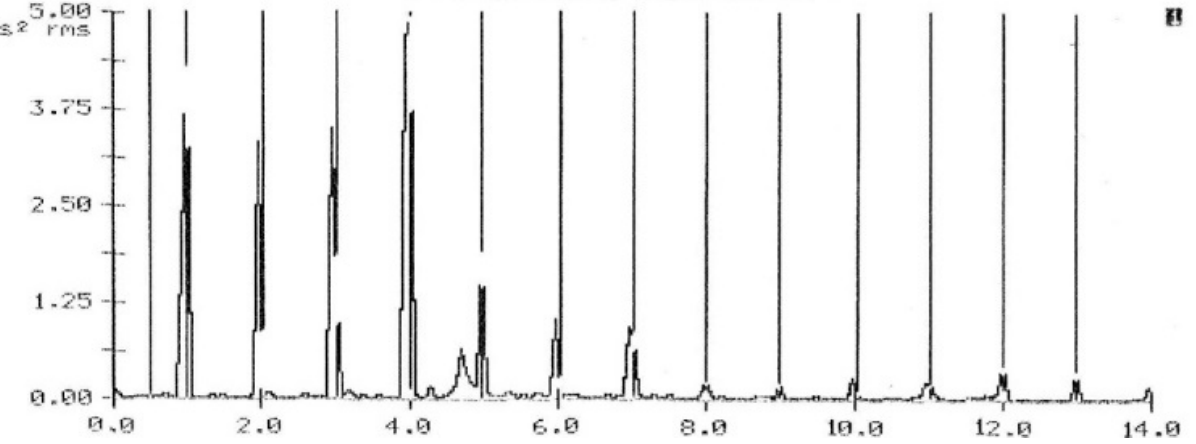
Figure 12. Synchronously averaged spectrum: compressor torsional vibration acceleration. Harmonic order: 1–14 orders.